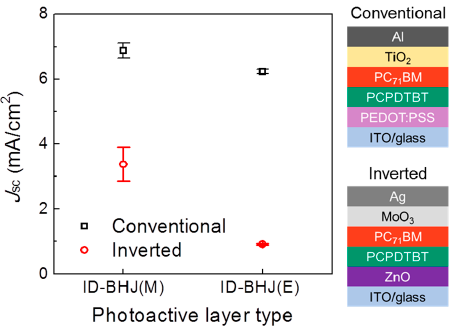
Figure 4. The current density ( J sc ) values are compared for different device configurations and PC 71 BM casting solvents.